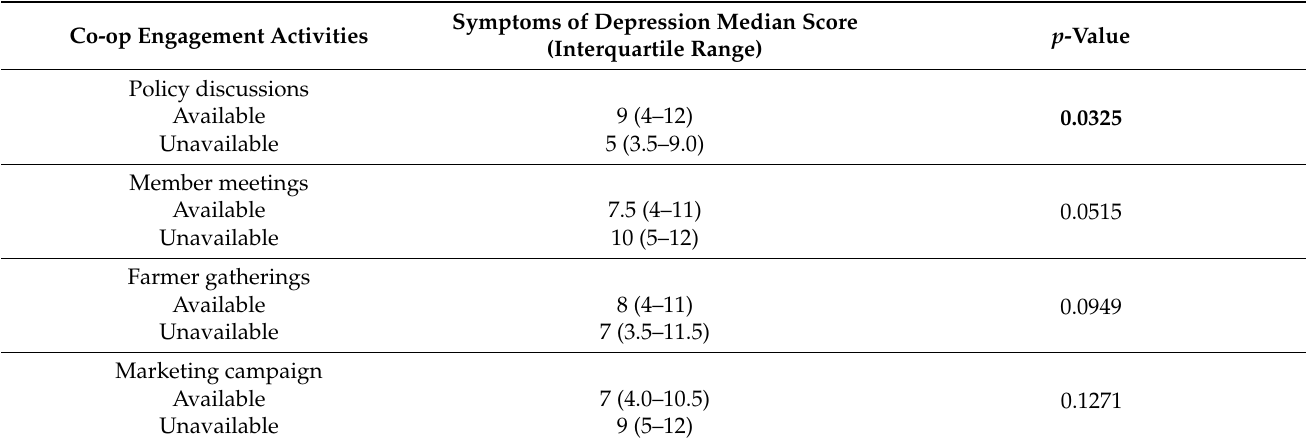
Table 5. Associations between co-op engagement activities and symptoms of depression